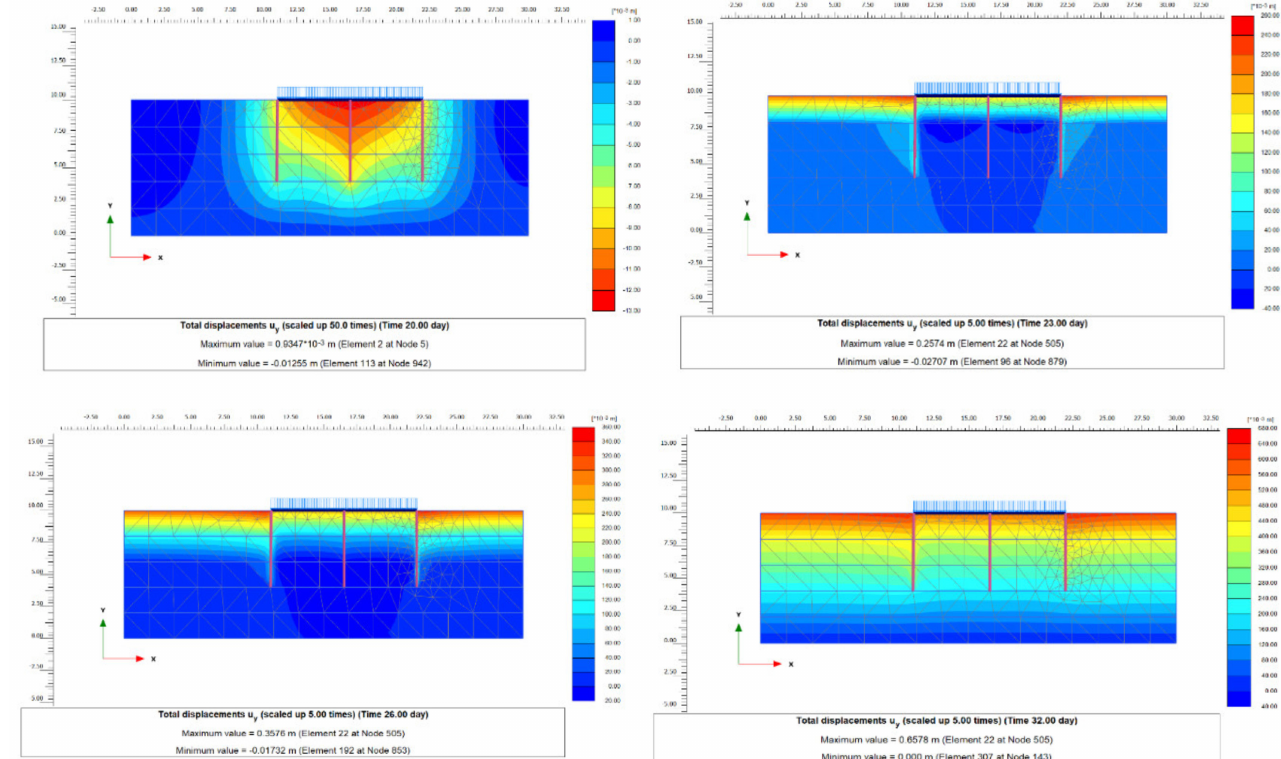
Figure 15. Settlement to progressive swelling